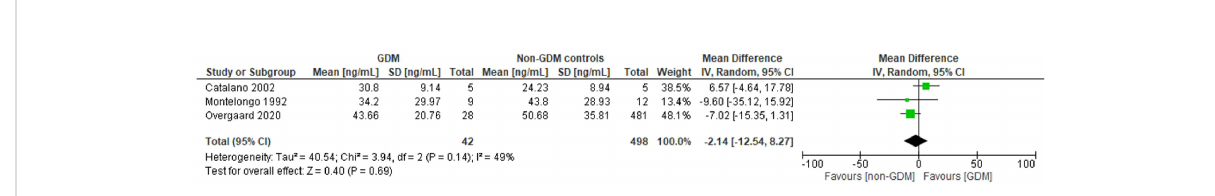
FIGURE 2A Forest plot showing meta-analysis of PRL levels in GDM vs non-GDM control women in early pregnancy ( ≤ 24 weeks) – 3